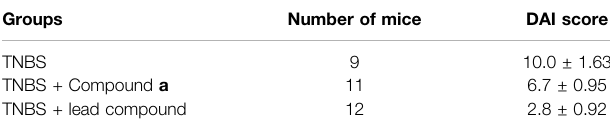
TABLE 6 | Intestinal in fl ammation scores of mice in each group.